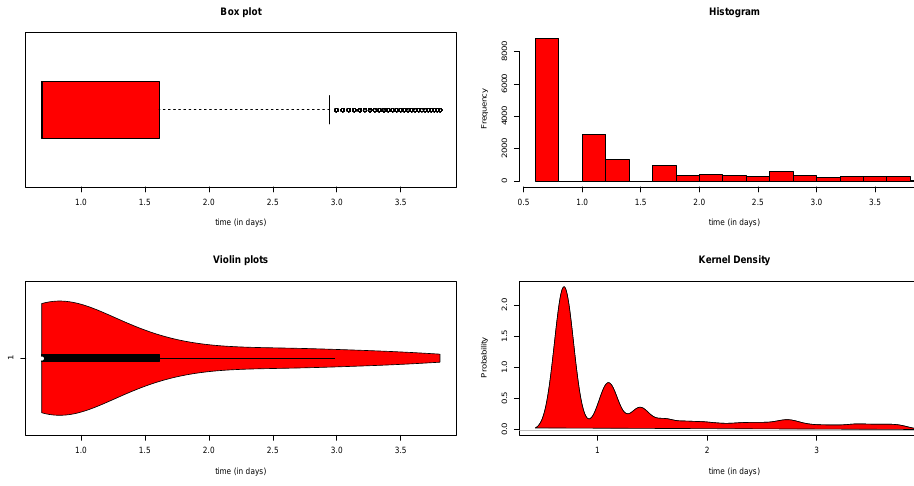
Figure 3. TTT plot for the Sudan COVID-19 data.